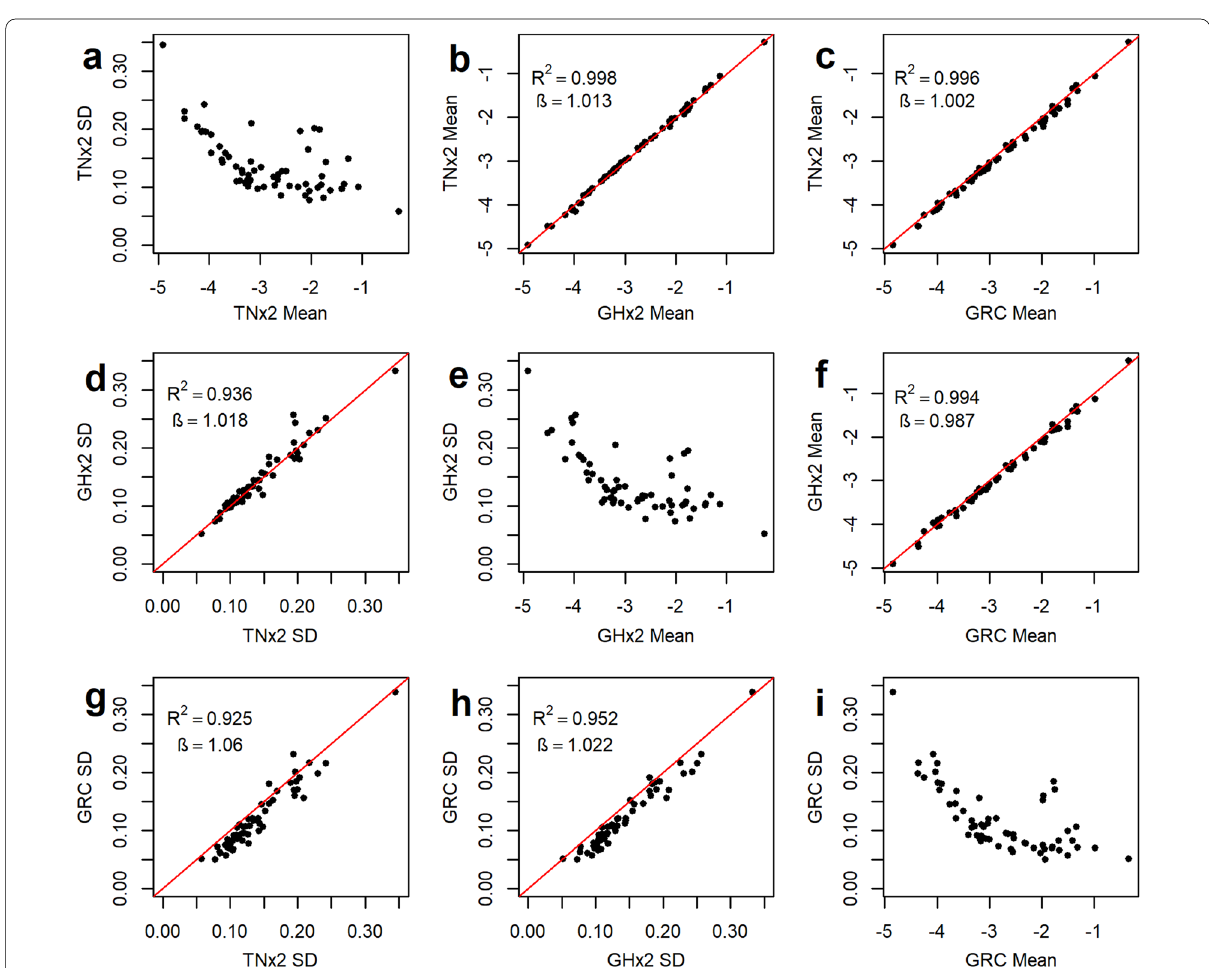
Fig. 4 Comparison of means and standard deviations (SD) of log 10 relative abundances using three sample preservation methods. Diagonal graphs (top left to bottom right) represent standard deviation plotted against the mean for TNx2 ( a ), GHx2 ( e ) and the GRC method ( i ). Above the diagonal are the plots of means against each other for the three different preservations methods ( b , c and f ). Below the diagonal are the plots of standard deviations against each other for the three different preservations methods ( d , g , h ). Red lines represent the diagonal line of